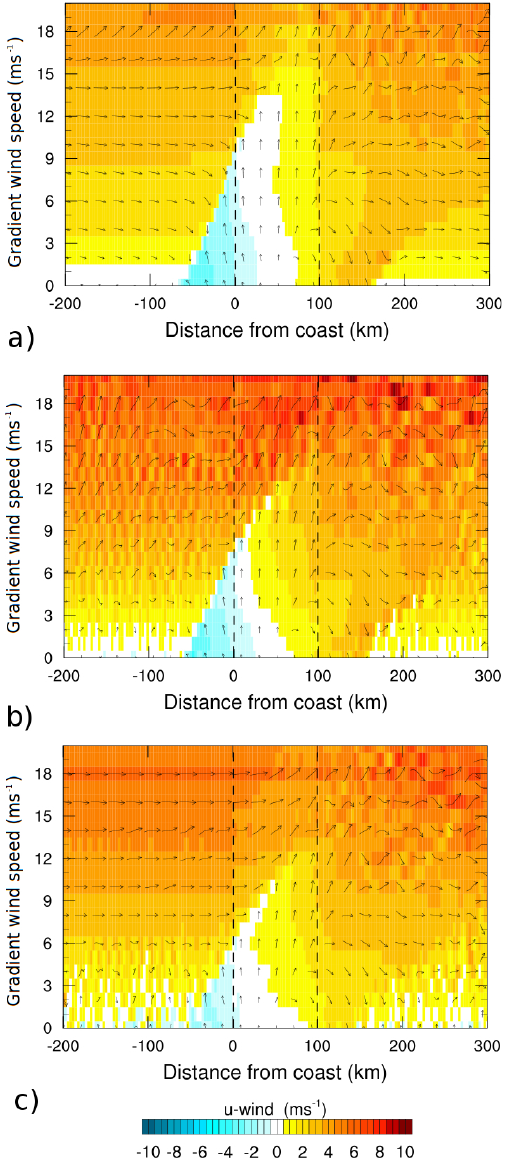
Fig. 21. Variations of the 10m u-wind component (color) and vec- tor wind speeds (arrows) with increasing west-east gradient wind strength at 17:00UTC using the (a) YSU, (b) MYJ and (c) MYNN PBL schemes with Coriolis acceleration. Distances are measured from the western coastal boundary with each coastline being de- picted by the dashed lines. The SST was set to 287K for all simula-